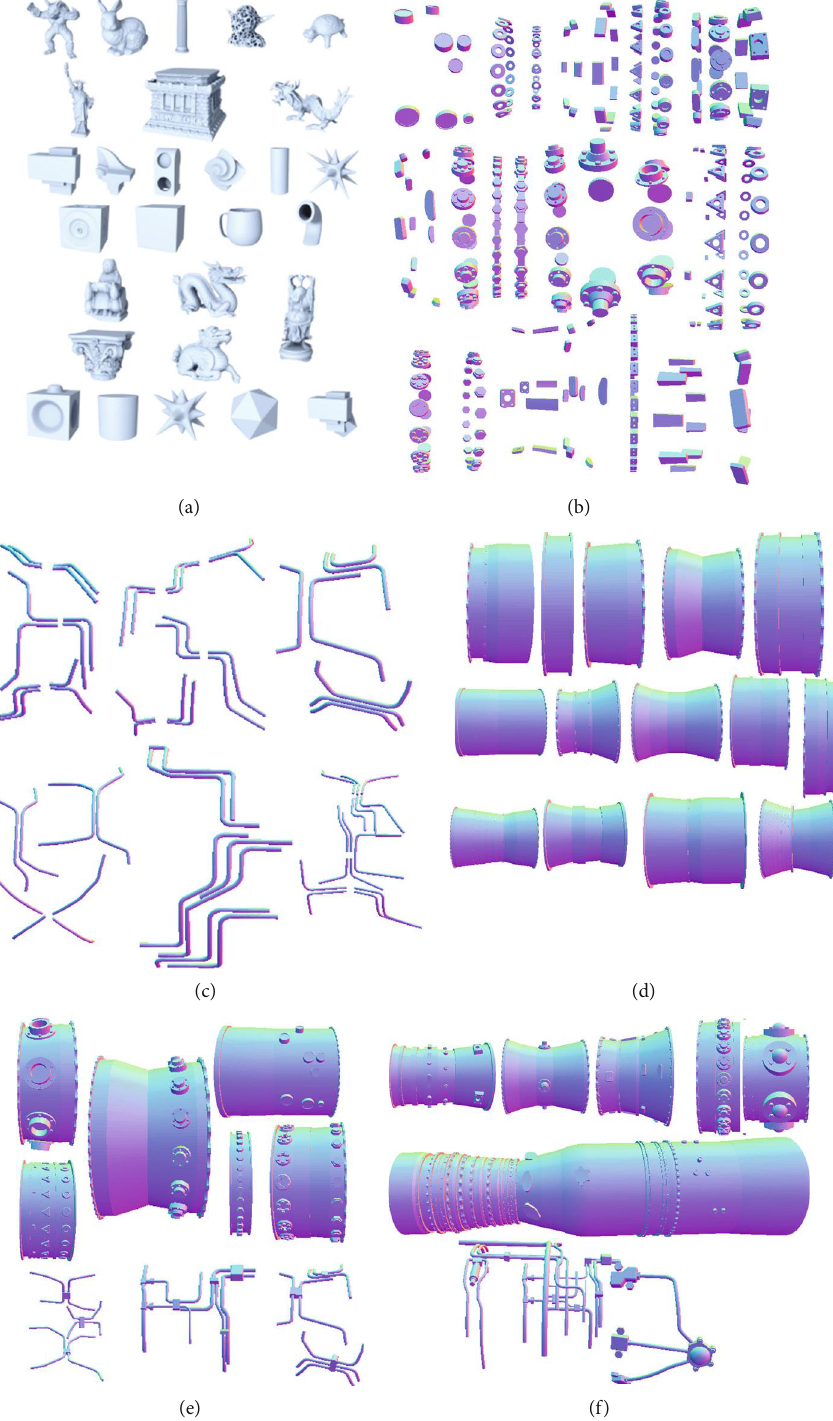
Figure 21: The datasets of denoising phase for SFP-PDNet. (a) basic denoising training set. The denoising training sets with di ff erent structural features (b) complex shape feature (c) pipeline feature (d) casing feature (e) validation set (f) test